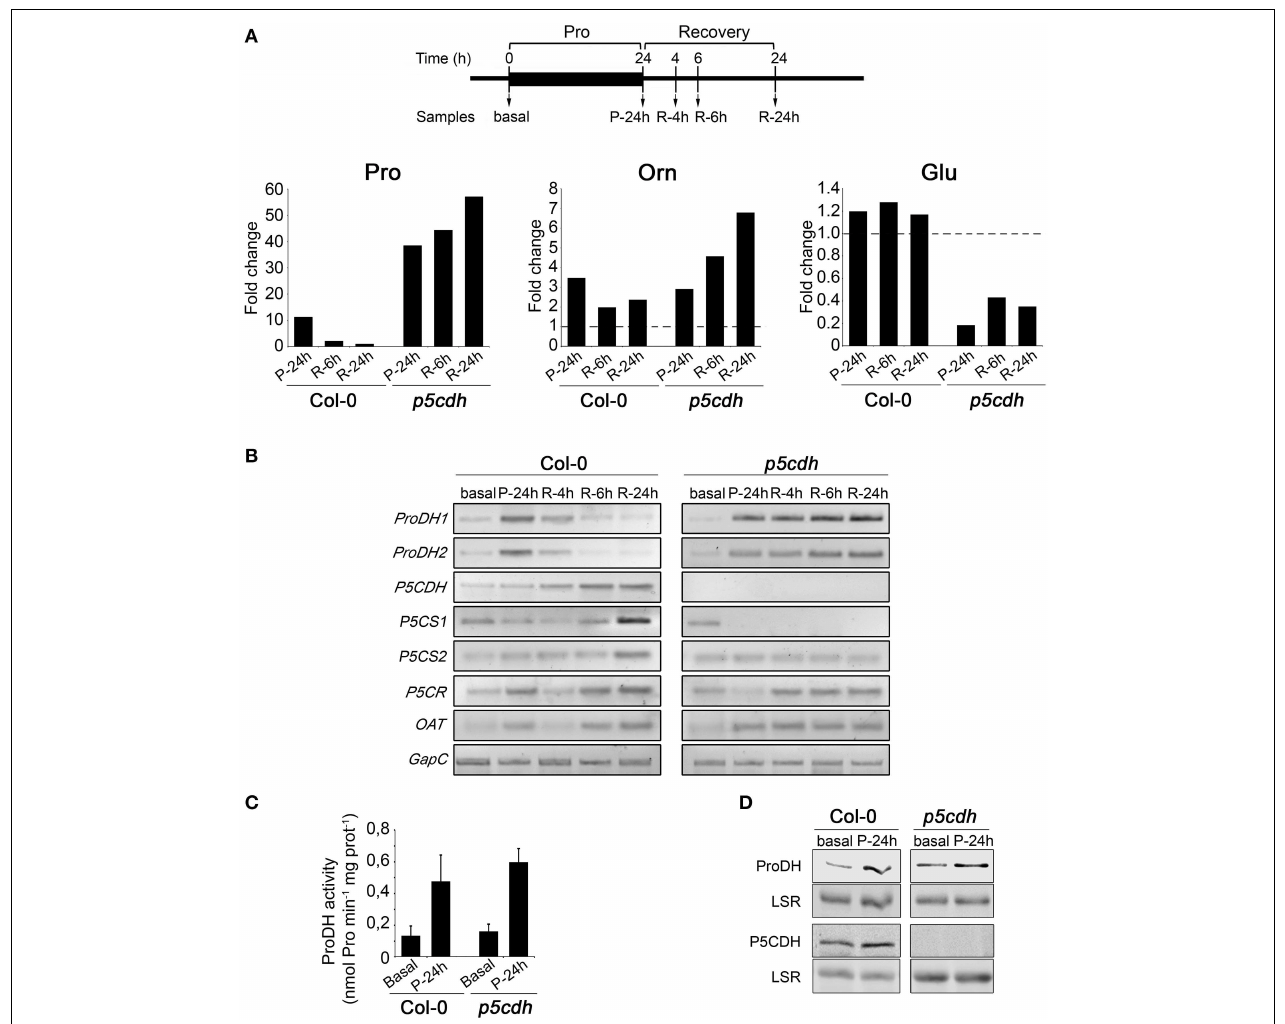
(B) Expression of genes of Pro metabolism evaluated as described in Figure 3B . (C) ProDH activity in total extracts of leaf samples taken at basal and P-24h stages. Values are expressed as nmol of Pro min − 1 mg protein − 1 . Each value is mean ± SE of two biological replicates. (D) ProDH and P5CDH content at basal and P-24h conditions examined by Western blot with polyclonal antibodies. LSR, large subunit of